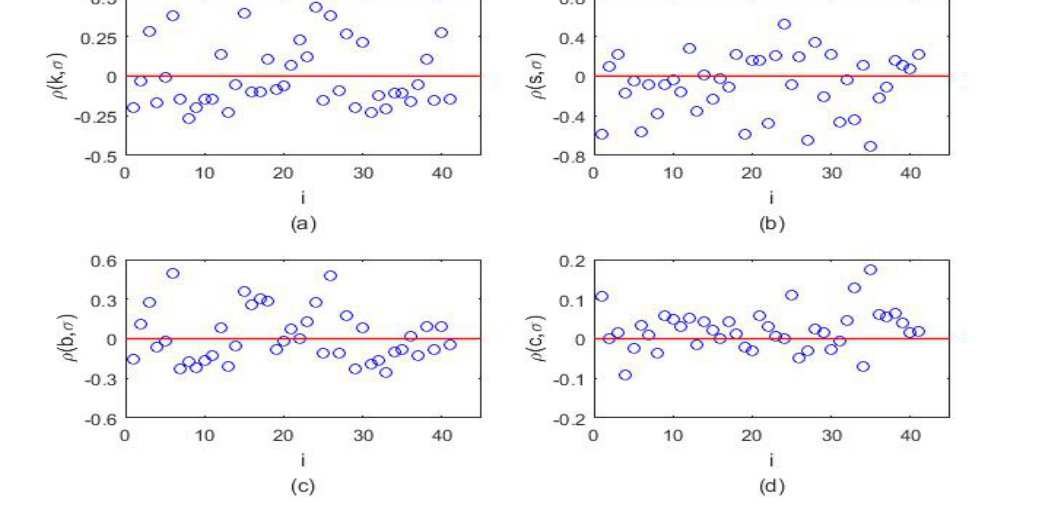
Figure 12. Pearson correlation coefficients between volatility and ( a ) node degree; ( b ) node strength; ( c ) betweenness centrality; ( d ) closeness centrality for each FX